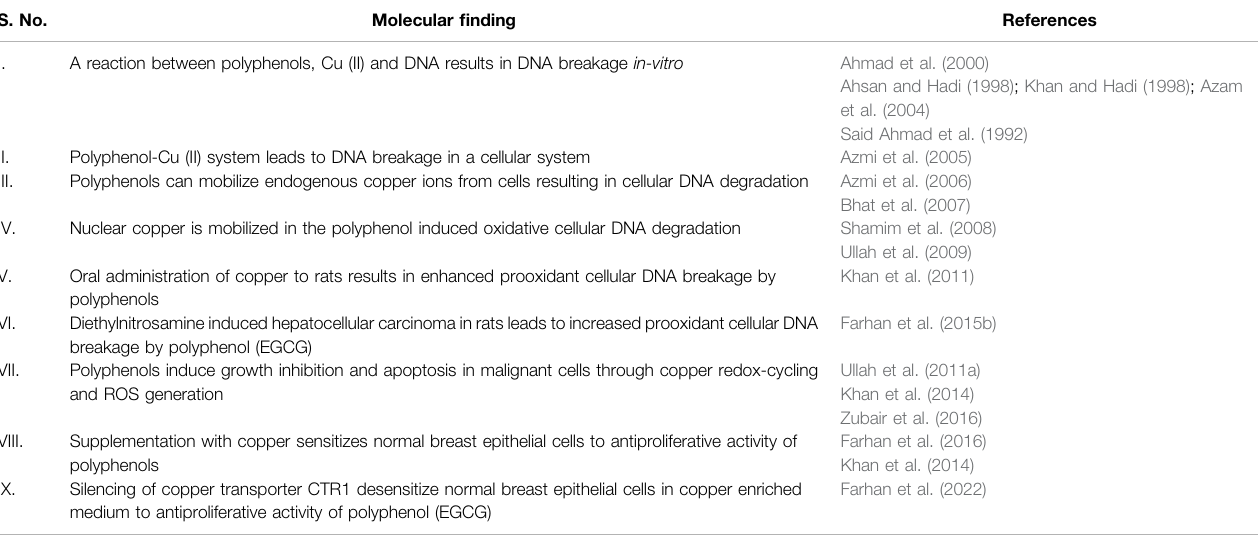
TABLE 3 | Molecular fi ndings to support the copper mediated prooxidant anticancer activity of plant polyphenols. S.